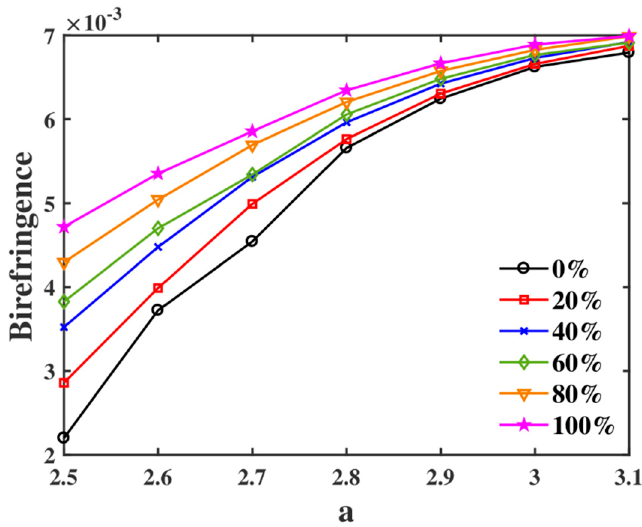
Figure 7. Birefringence of the proposed fiber for different core length to width ratio at f = 2.8 THz for different volume of kerosene with petrol.